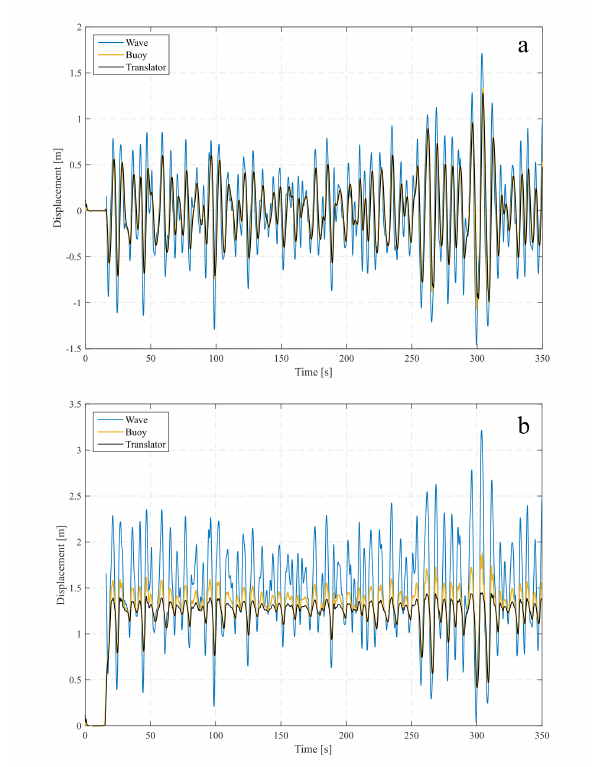
Figure 3. Simulated behavior of the buoy and translator positions in semi-random waves. The tidal level is equal to ( a ) 0 m; and ( b ) +1.5